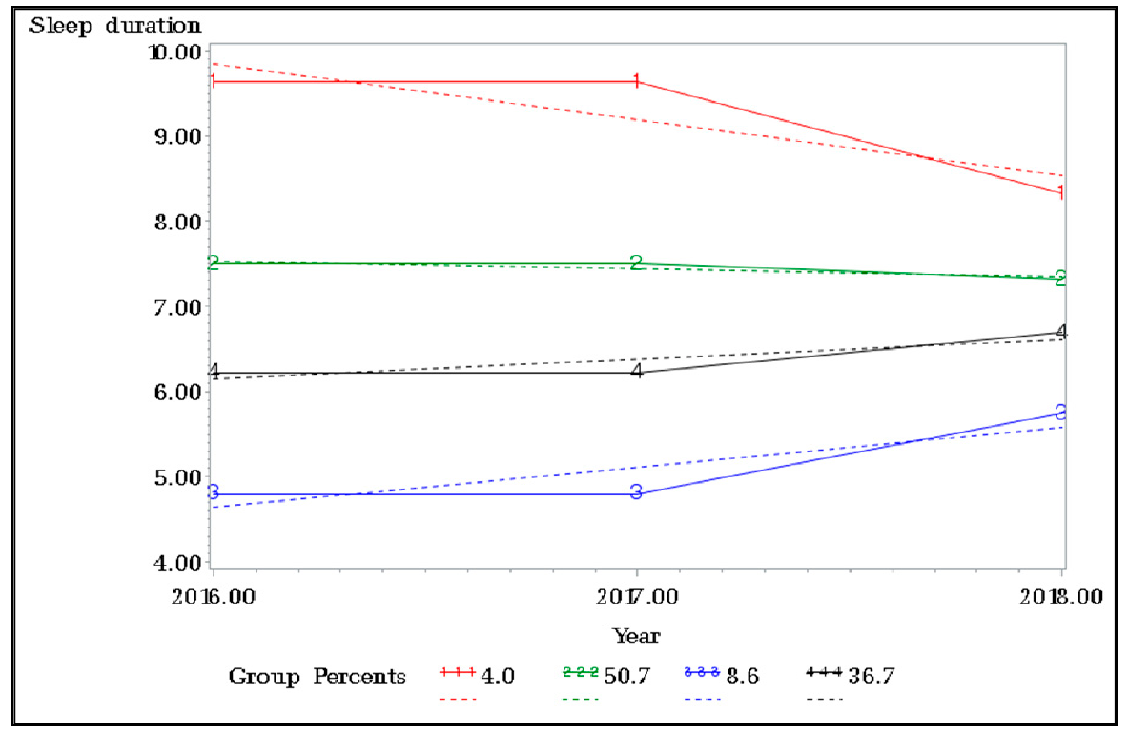
Figure 1. The sleep duration trajectory groups among the people with physical disabilities. Table 3. The relationship between sleep duration patterns overtime and self-rated depressive symptom.